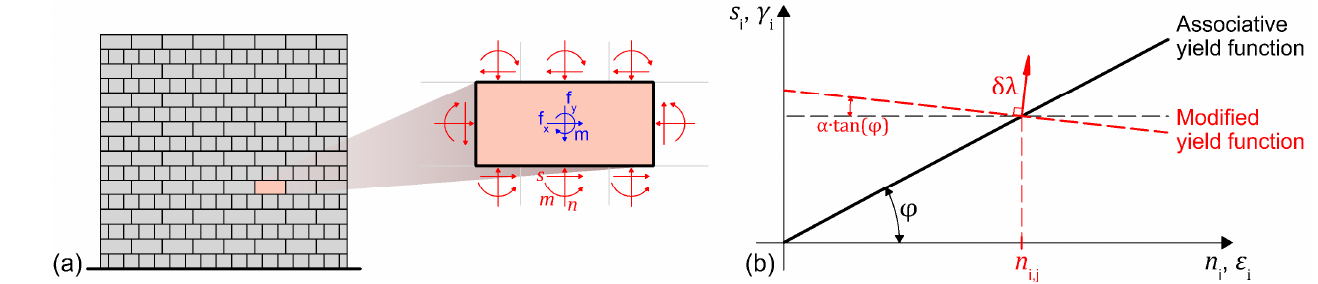
Figure 2. ( a ) Dry-stack masonry wall, ( b ) yield function for the non-associative